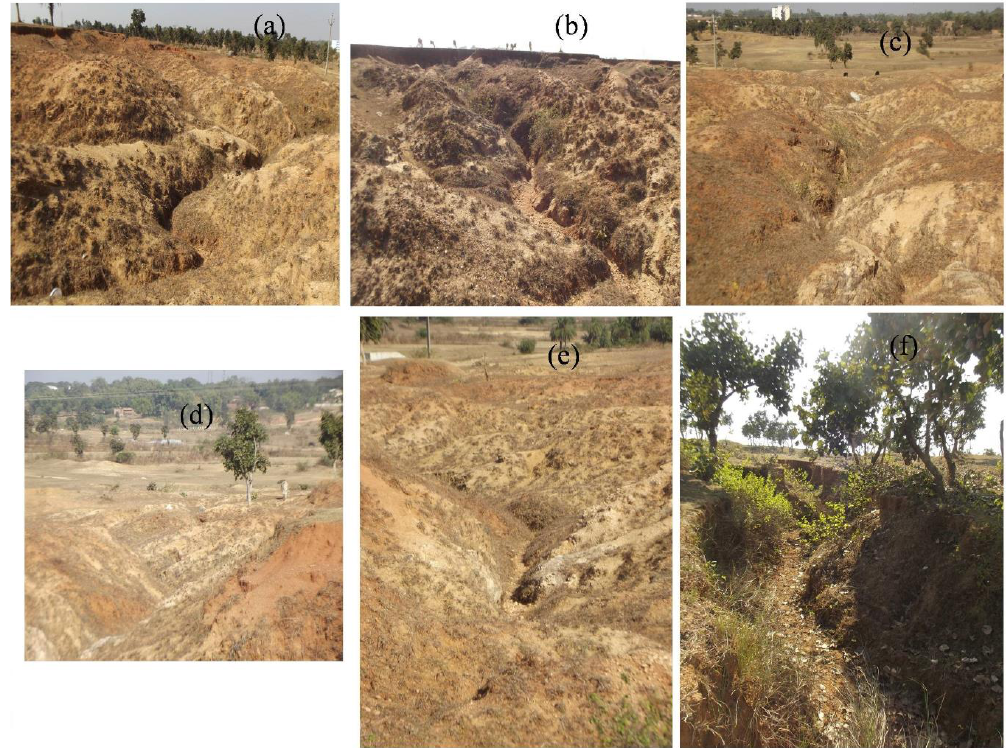
Figure 3. Field photographs of gullies of fallow land and vegetation-covered areas ( a ) Charakmara (24˚00'36"N, 86˚54'48"E), ( b ) Dhainghati (23˚57'56" N, 87˚00'34" E), ( c ) Agaia (23˚57'15" N, 87˚10'14" E), ( d ) Bamombhuin (23˚56'41" N, 87˚12'07" E), ( e ) Hesaltanr (23˚56'13" N, 87˚07'31" E), ( f ) Prasadpur (23˚57'03" N, 87˚12'36" E)